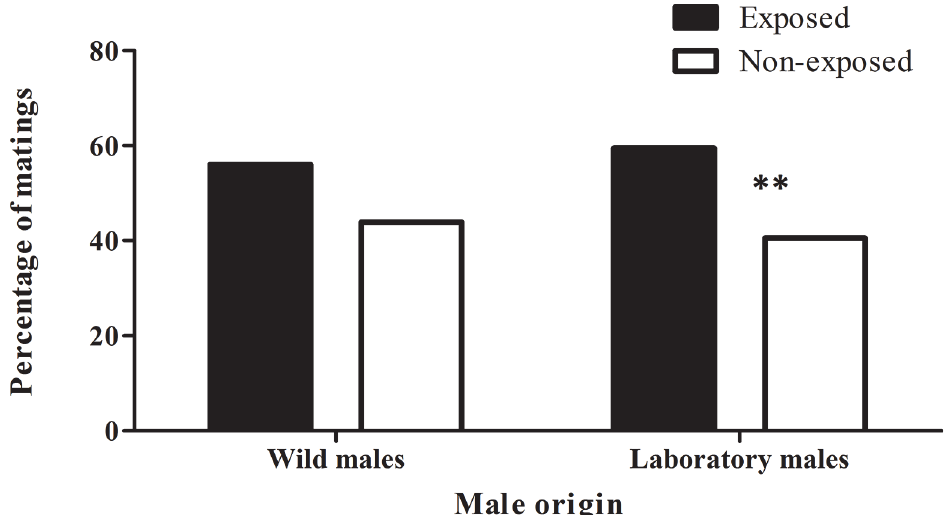
Fig 4. Effect of artificial blend exposure on male mating success. Percentage of matings obtained by wild and laboratory Anastrepha fraterculus males, exposed and non-exposed to an artificial blend containing a subset of volatile compounds released by guava fruits (( E )-3-hexenal, β -myrcene, ( E )- β -ocimene, ethyl butanoate, ethyl hexanoate, α -humulene, and limonene). Asterisks indicate G-Test, P = 0.005, N = 330 for laboratory males. For wild males, G-Test, P = 0.179, N = 582. In mating tests, wild females were used with wild males, while laboratory females were used with laboratory